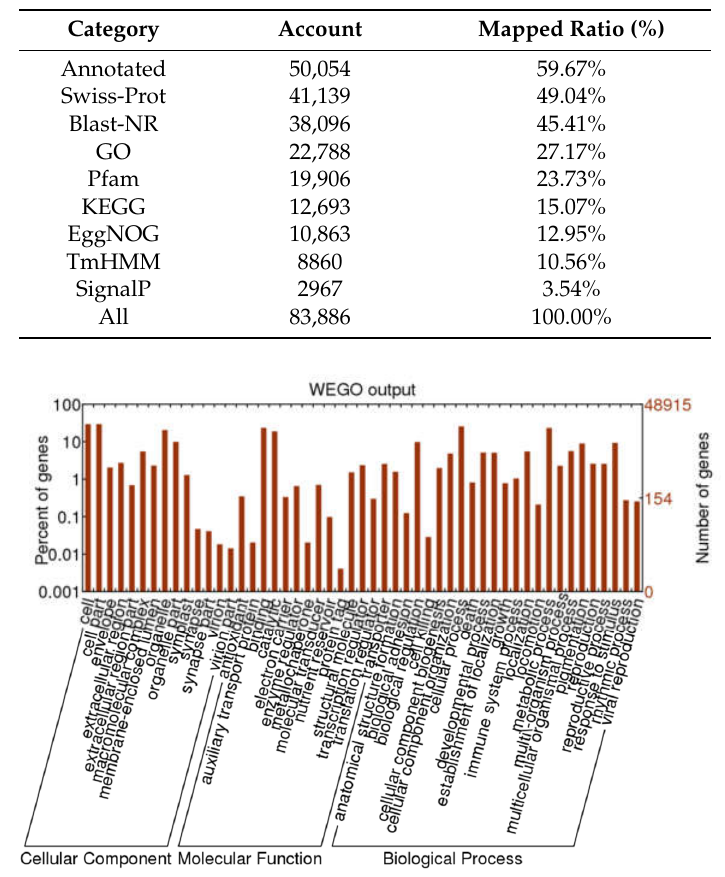
Figure 3. Functional classification and pathway assignment of assembled unigenes by KEGG.